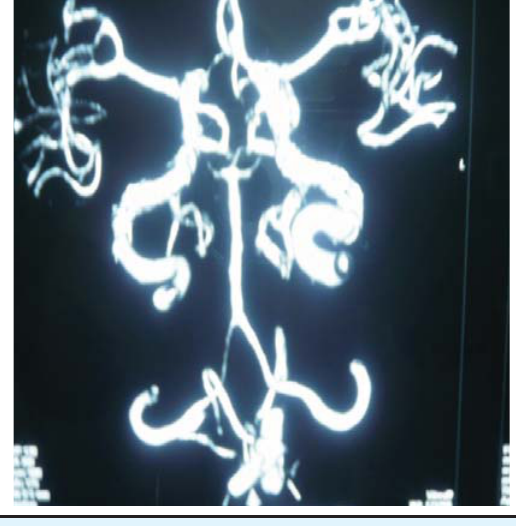
Figure 3. CT angiogram depicting total occlusion of the neck of both the distal PICA aneurysms and obliteration of the sacs. The clips are in